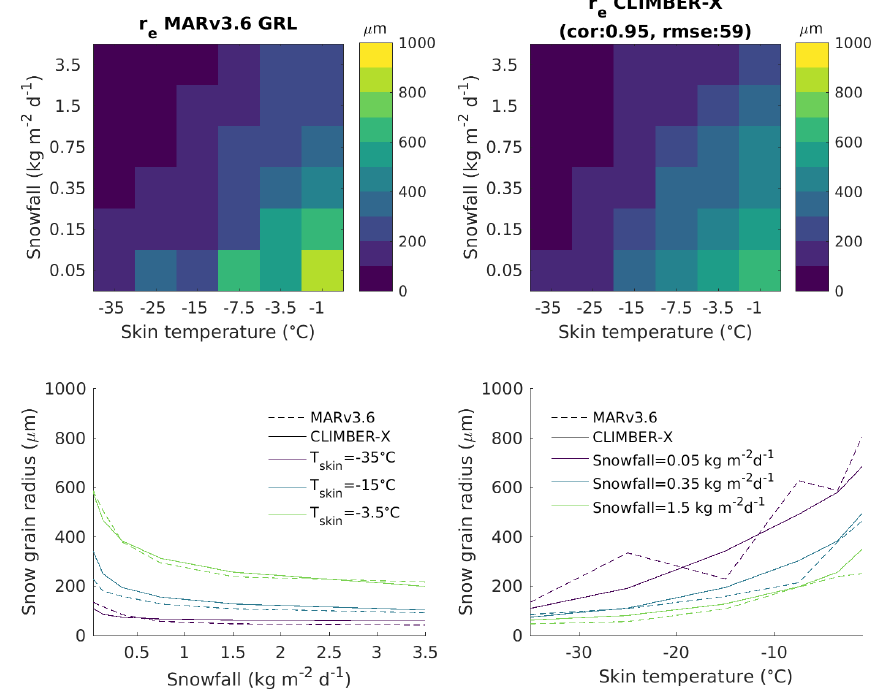
Figure D1. Snow grain size parameterization as a function of skin temperature and snowfall